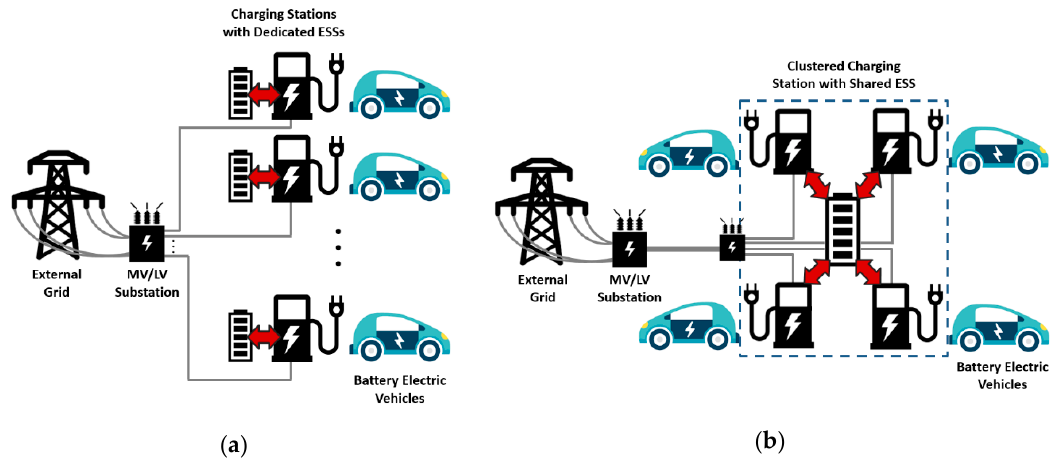
Figure 1. ( a ) Single charging station (CS) architecture with dedicated energy storage system (ESS); ( b ) 4-Clustered CS architecture with one shared ESS.